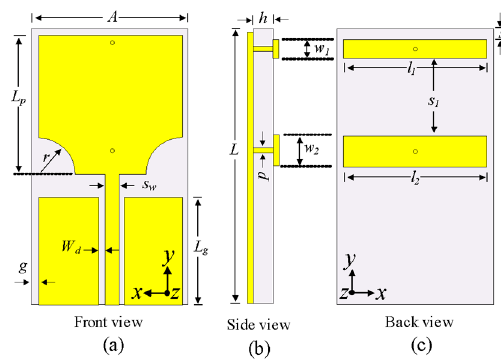
Figure 2. Geometry of proposed antenna: ( a ) front view ( b ) side view, and ( c ) back view.